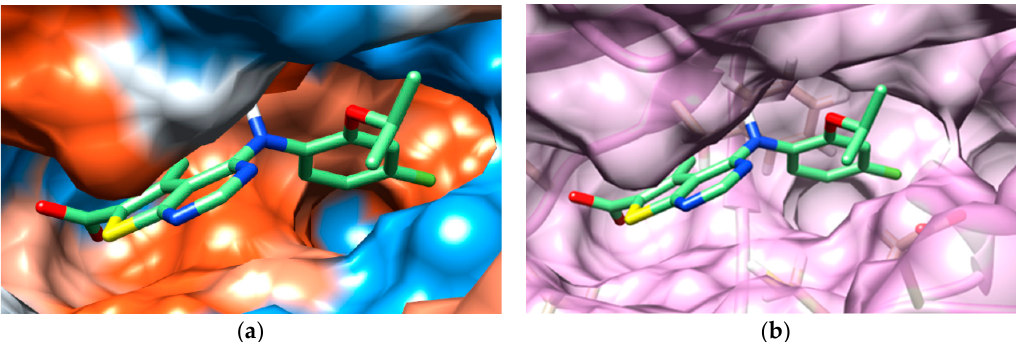
Figure 3. Docking of compound 1 in MNK2 crystal structure. ( a ) Predicted binding mode of compound 1 in MNK2-D228G (PDB; code: 2HW7) coloured by hydrophobicity surface: from blue for the most hydrophilic, to white, to red for the most hydrophobic. ( b ) Important regions within the MNK2 active site and proposed interactions with compound 1 . Molecular graphics and analyses were